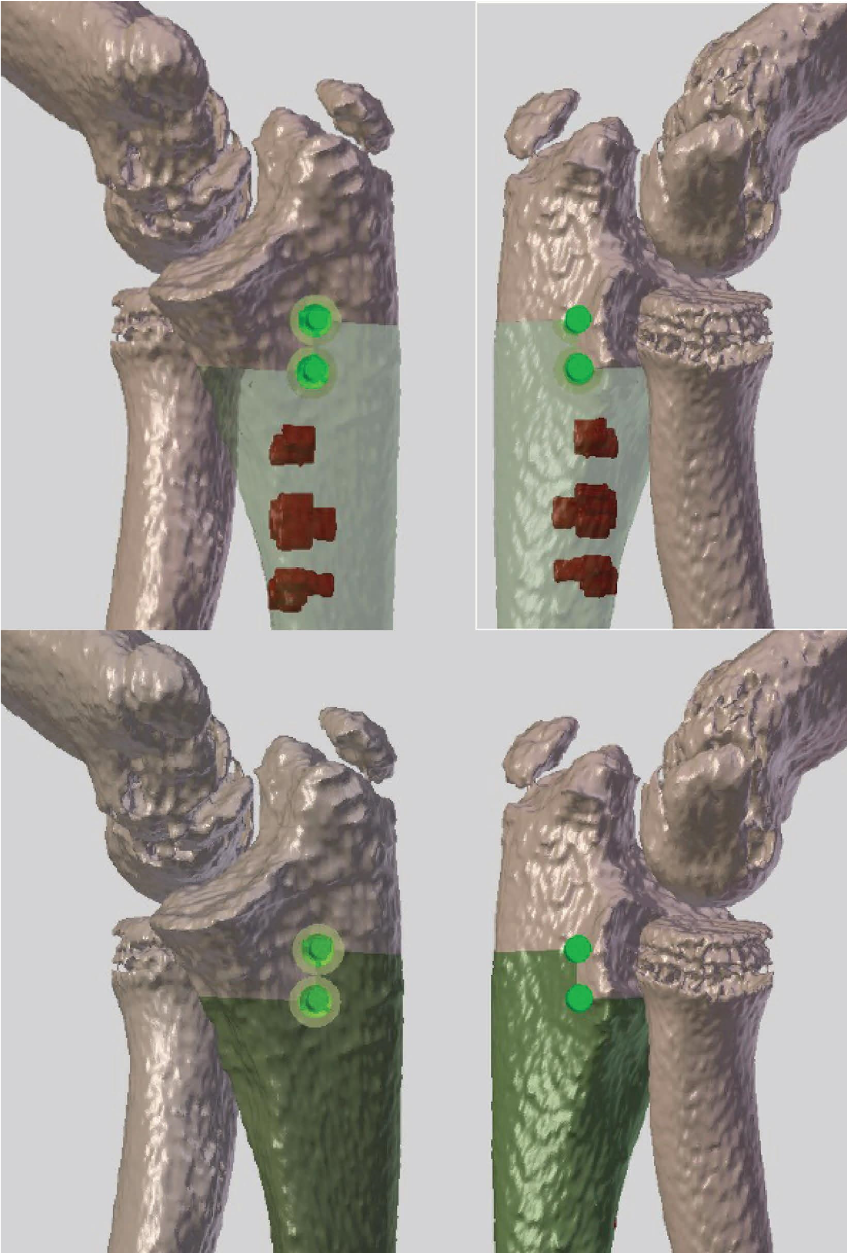
Figure 2: Te same patient mentioned in Figure 1. Top left and right: the segmented tumor on MRI was merged with the CTscan. Te tumor is in red (there were 3 small separated tumoral areas in the proximal ulna). Te picture gives the detail of the preoperative planning for the proximal section. A step cut was chosen to improve stability. Te chosen margin was 5mm in order to preserve the joint. Bottom: the green zone in the ulna is the area that is planned to be resectioned. Left: medial view and right: lateral